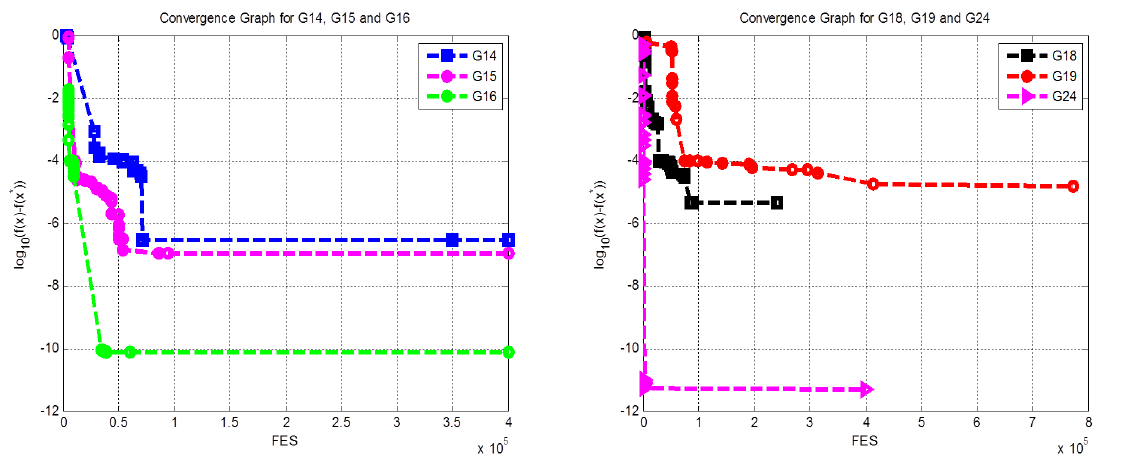
Figure 4. Convergence graph for G14 to